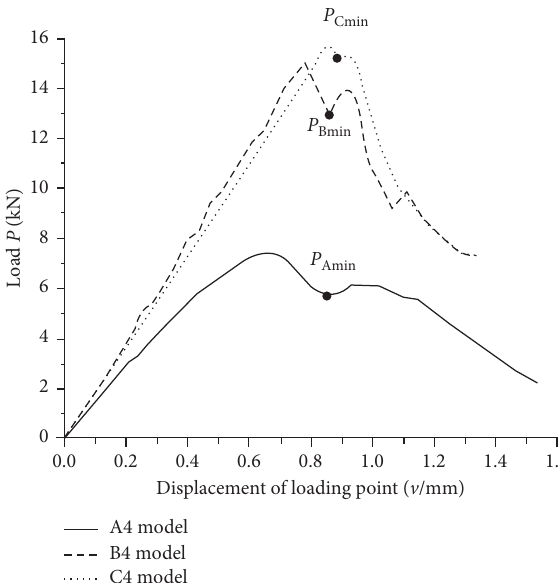
Figure 27: P - v curve of the ECFR